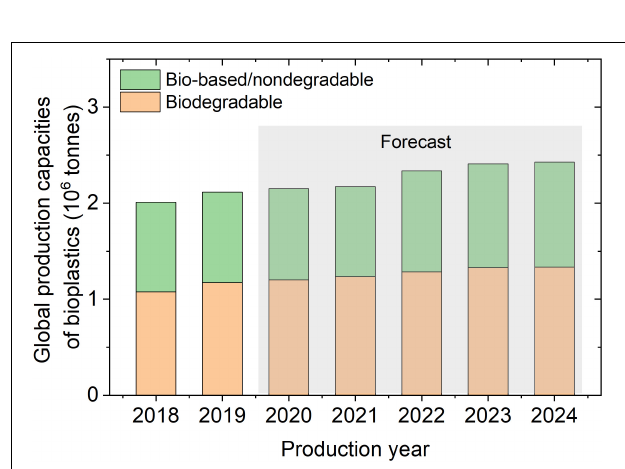
FIGURE 2 | Current and forecast global production capacities of bioplastics (European Bioplastics e.V.,